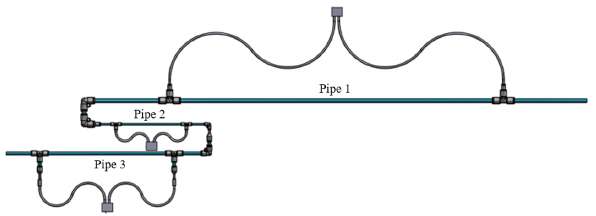
Figure 2: Pipe viscometer comprising three pipes of various di- ameters and lengths, and corresponding pressure transducers connected to differential pressure